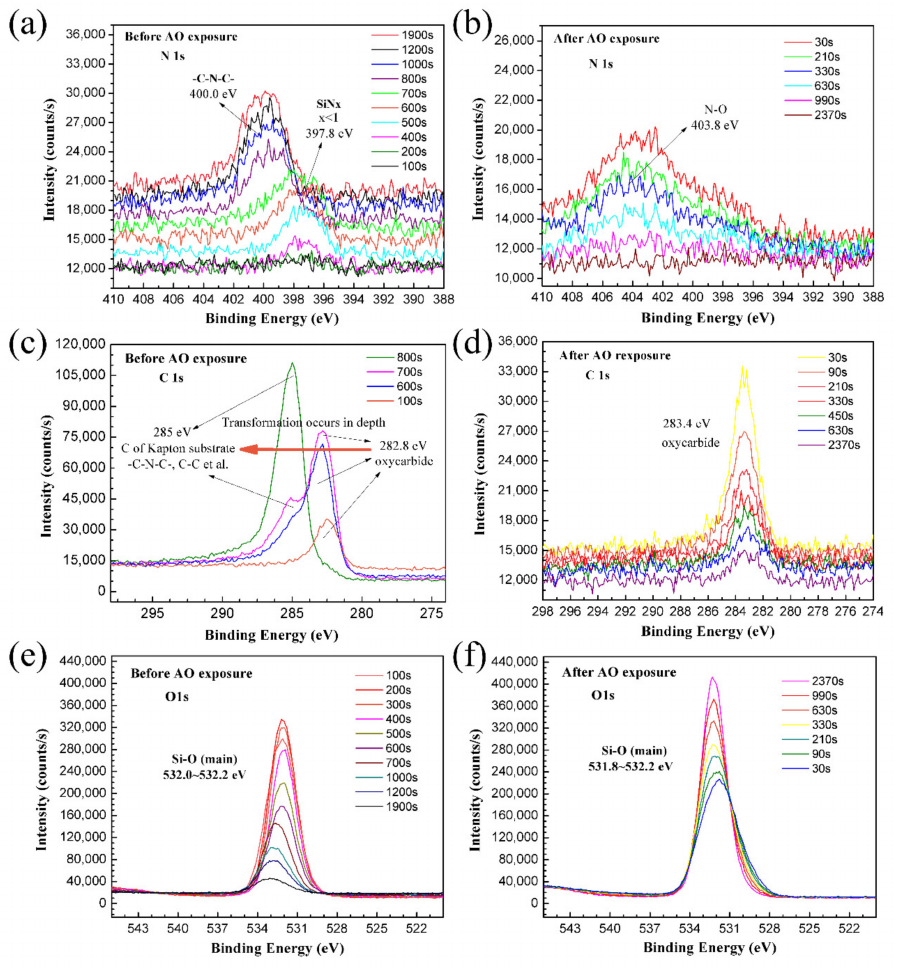
Figure 8. High-resolution XPS depth profiles of N 1s, C 1s and O 1s in the ( a , c , e ) as-prepared and ( b , d , f ) AO-exposed PHPS coating (Total fluence of AO exposure: 1.5 × 10 21 atoms cm − 2